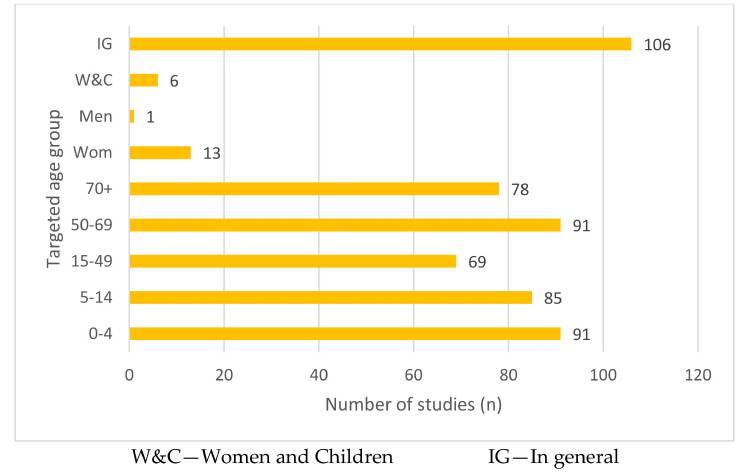
Figure 5. Targeted age group against WHO regional